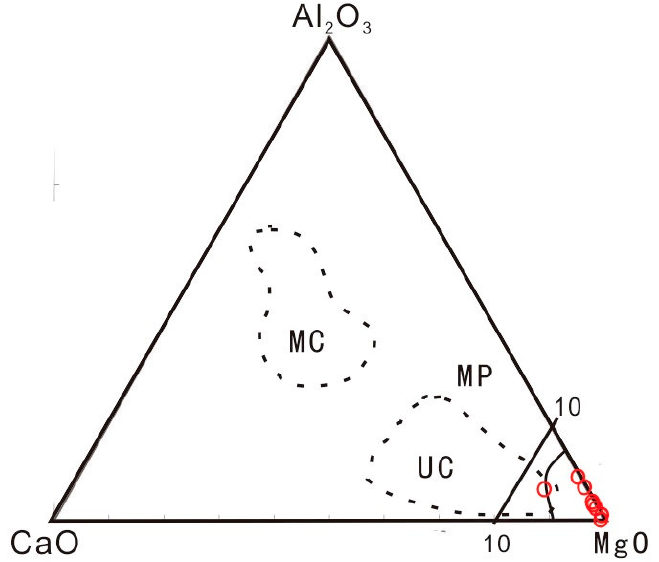
Figure 8. Al 2 O 3 -CaO-MgO graph in “Laoshan Jade” [38]: MC—mafic cumulate; UC—ultramafic cumulate; MP—metamorphic peridotite.